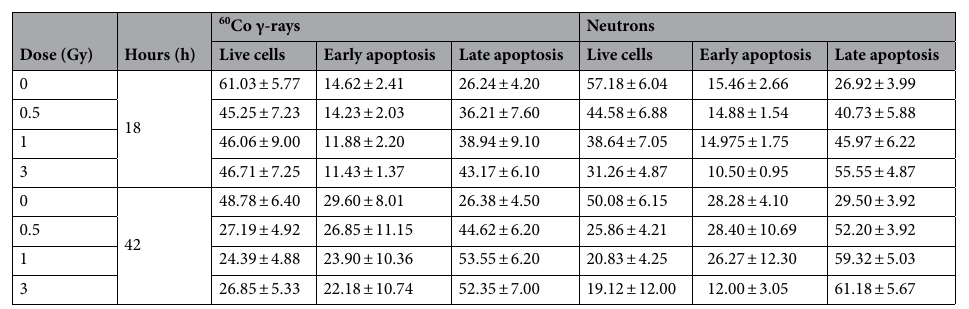
Table 2. This table represents mean percentage (standard error of the mean (SEM)) of living, early and late apoptotic CD34 + cells of the same donors were irradiated with three different radiation doses of 0, 0.5, 1 and 3 Gy of 60 Co γ-rays and neutrons after 18 and 42 h (n = 13).